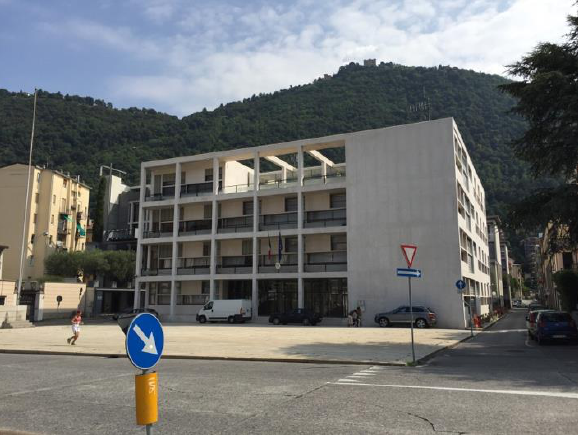
Figure 1. Casa del Fascio (Authors’ capture,